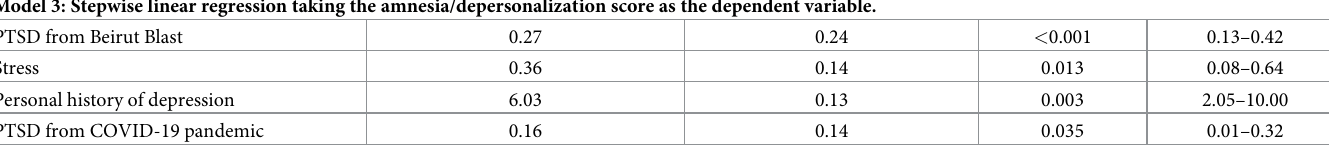
Variables entered in the model: PTSD from Beirut Blast, Stress (BDS score), PTSD from economic crisis, Personal history of PTSD, Personal history of anxiety disorder, Personal history of depression, Depression (PHQ9 score), Anxiety (LAS score), PTSD from COVID-19 pandemic, PTSD from Beirut Blast; PTSD = Post traumatic stress disorder. Nagelkerke R 2 = 32.2%.